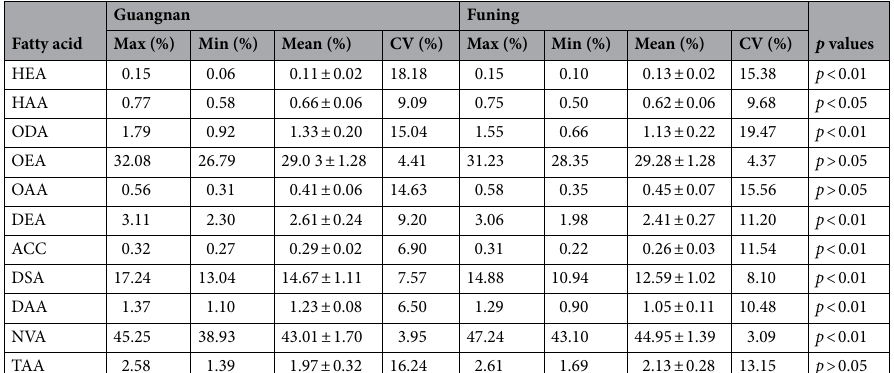
Table 3. Fatty acid composition of seed oil from seeds taken from individual trees in Guangnan and Funing (as methyl esters). HEA hexadecenoic acid, HAA hexadecanoic acid, ODA octadecadienoic acid, OEA octadecenoic acid, OAA octadecanoic acid, DEA dodecenoic acid, ACC arachidic acid, DSA docosenoic acid, DAA docosanoic acid, NVA nervonic acid, TAA tetracosanoic acid. p values indicate levels of significance in the differences between Guangnan and